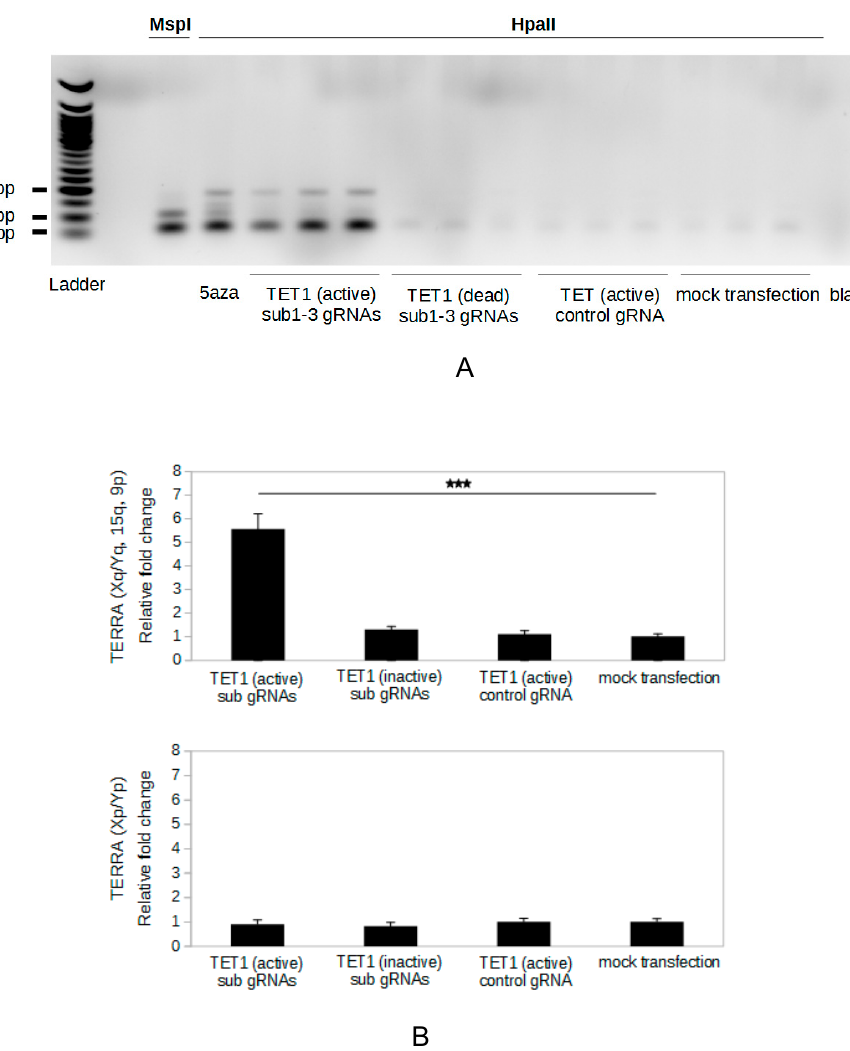
Figure 2. Demethylation of the subtelomeric 29 bp repeats by the CRISPR-dCas9-TET1 system is associated with an up-regulation of TERRA. HeLa cells were transfected with the CRISPR-dCas9-TET1 system with TET1 active or catalytically dead and subtelomeric gRNAs (sub1-3) or control gRNA. Genomic DNA and RNA were extracted 96 h post-transfection. Mock transfected HeLa cells were used as control. ( A ) The methylation of the 29 bp repeats was analyzed using the method described in Figure 1B: 1 µ g of genomic DNA was digested with HpaII, 1 / 20 of the elongation reaction was amplified by PCR (35 PCR cycles), and PCR products were run on a 1.5% bromure ethidium (BET)-agarose gel. Three independent transfection experiments were done for each condition. Genomic DNA from HeLa cells treated with 5-aza-dC and digested by HpaII (5aza) or untreated and digested with MspI were used as positive controls. A sample without DNA (blank) was used as negative control. Ladder is the 50 bp DNA ladder (New England BioLabs). ( B ) TERRA from subtelomeres Xq, Yq, 15q, 9p and TERRA from subtelomeres Xp and Yp were quantified by RT-qPCR (reverse transcription-quantitative PCR) using TF / TR and Xp-R / Xp-F primer pairs, respectively. Levels were normalized to GAPDH (glyceraldehyde-3-phosphate dehydrogenase) mRNA, and all values were compared to mock transfected sample. The bars are average values from three biological and two technical replicates for each sample. Error bars are standard deviations. p values were calculated by paired two-tailed Student’s t-test ( n = 3). *** p <